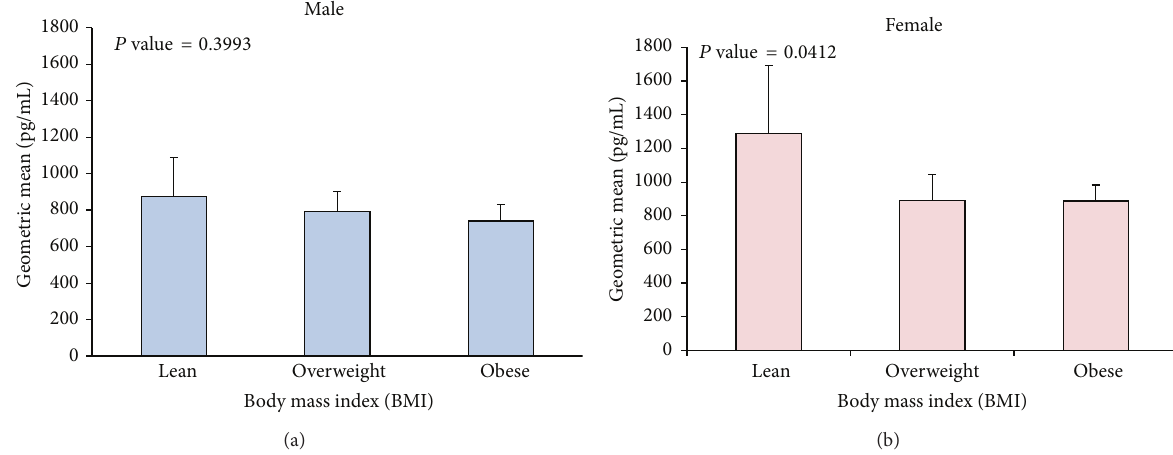
Figure 3: Age adjusted geometric means of ghrelin level and their effect on BMI. (a) Age adjusted ghrelin levels according to different classes of BMI (BMI between 18.5 and 24.9 was considered lean, 25 and 29.9 was considered overweight, ≥ 30 was considered obese) showing no significant change in ghrelin level across the different BMI classes in Arab males. (b) Females on the other hand showed significant decrease in ghrelin level in obese subjects compared to lean and overweight ( 𝑃 -trend = 0.0412).